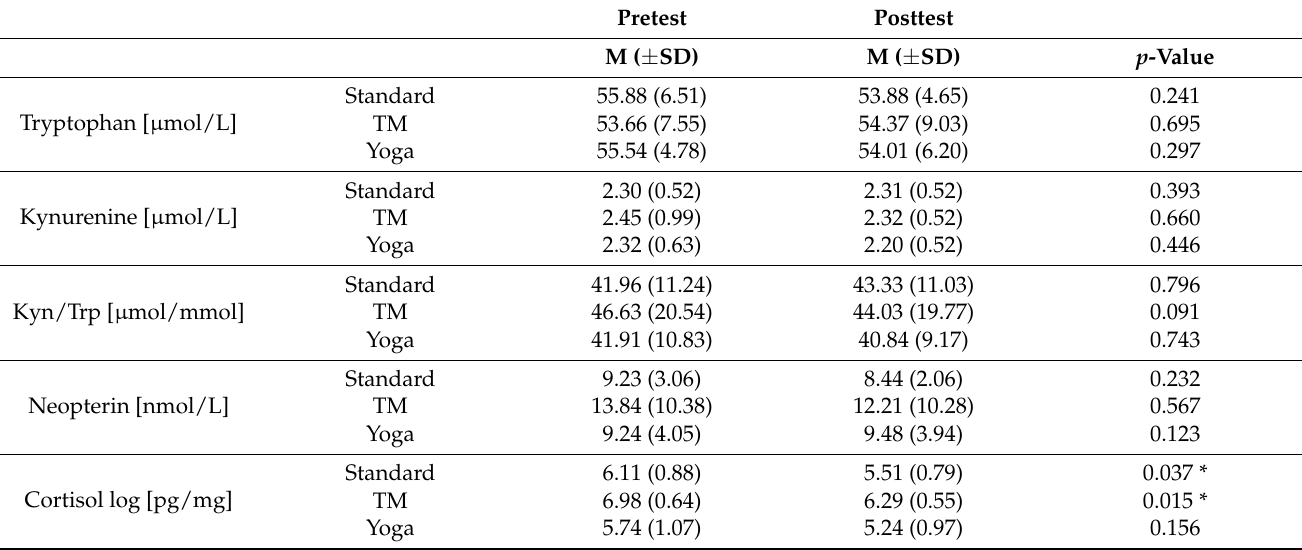
Table 5. Descriptive data of biomarker